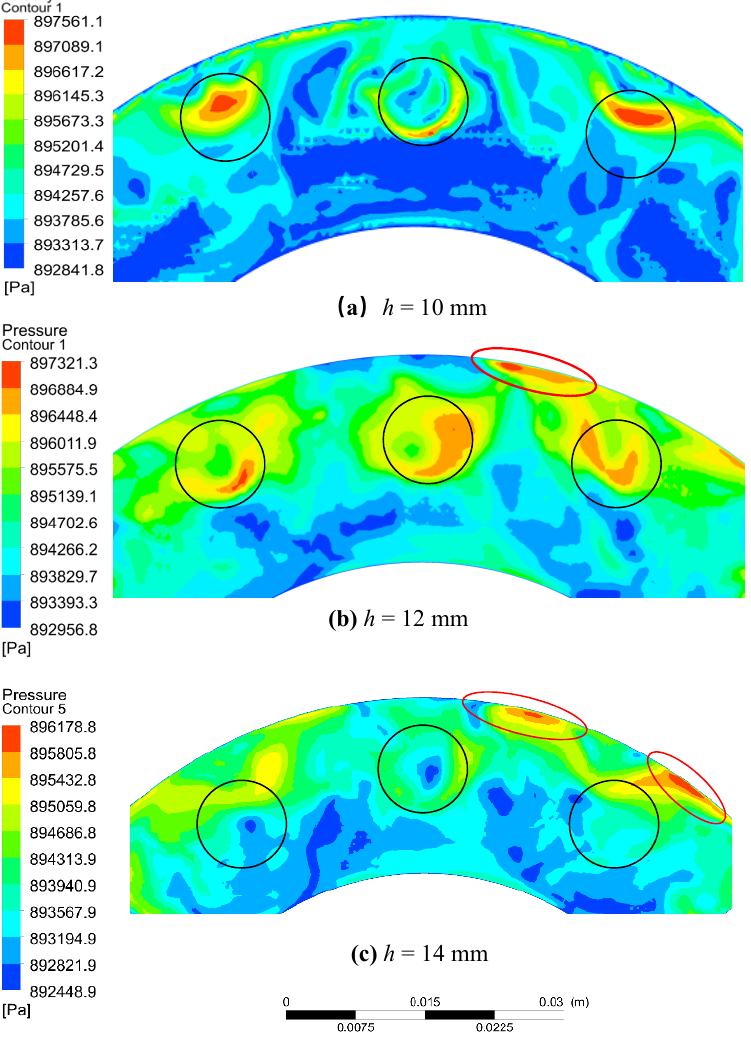
Figure 6. Effects of waterway height on crown flow velocity ( a ) h = 10 mm; ( b ) h = 12 mm; ( c ) h = 14 mm.